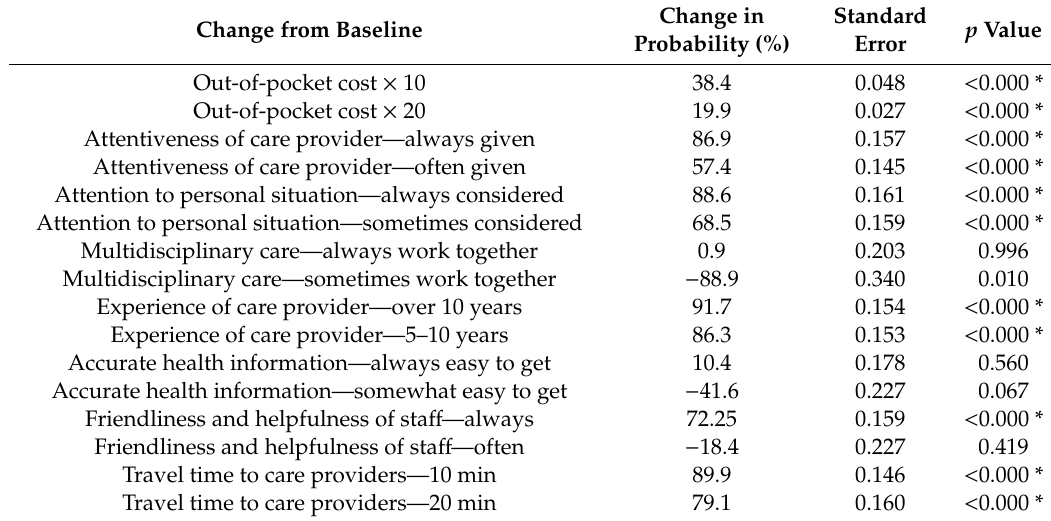
Table 4. Changes in probabilities of choosing the baseline CHS †